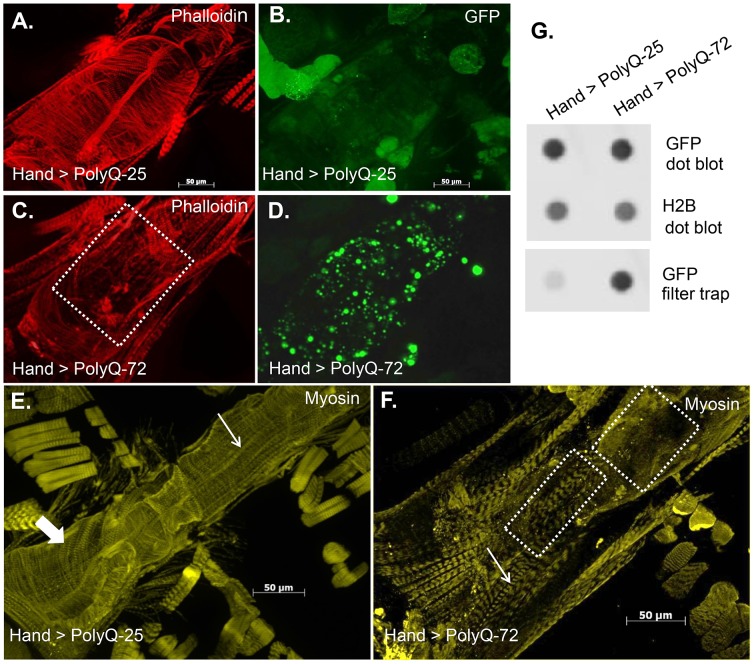
Mutant PolyQ causes structural defects and GFP-positive aggregates in the fly heart.(A) Hearts from 3-week old PolyQ-25 controls show typical circumferential arrangements of actin-containing myofibrils within the cardiomyocytes and (B) homogeneously distributed GFP in the cardiomyocytes. (C) In hearts expressing PolyQ-72 the myofibrillar organization is severely disrupted (region indicated by dashed lines) with a loss of actin-containing myofibrils. (D) GFP-positive aggregates of various sizes are distributed throughout the cardiomyocytes in hearts expressing PolyQ-72. (E) Heart from 3-week old fly expressing PolyQ-25 shows myosin-containing myofibrils. This control heart shows typical circumferential arrangement of myosin-containing myofibrils (thick arrow). (F) The circumferential arrangement of myosin-containing myofibrils is nearly lost upon expression of mutant PolyQ-72 (F, dashed boxes). Thin arrows in E and F indicate myofibrils in the non-cardiac longitudinal fibers. (G). Dot blot protein assay (top) showing similar overall expression of Htt-PolyQ-25 GFP (control) and Htt-PolyQ-72 GFP protein relative to histone H2B (middle, loading control). Filter trap assay (bottom) shows more GFP positive protein aggregates present in the Htt-PolyQ-72 GFP expressing hearts compared to control hearts.